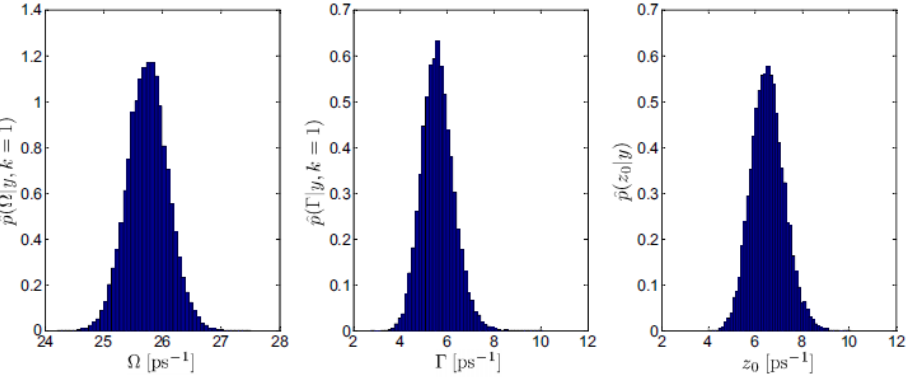
Figure 1. An example of the posteriors obtained from the Bayesian analysis of the INS spectra collected on liquid Au at Q = 10 nm − 1 . Reproduced from Ref. [12]. Copyright (2016) of American Physical